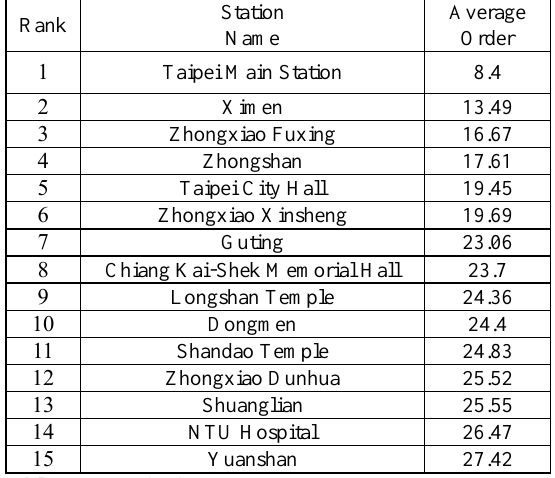
Table 2 : a list of infection order, according to the agent-based